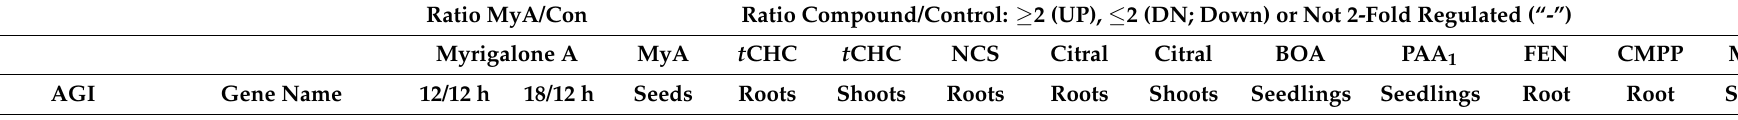
Table 4. Comparison of compound treatment on the expression of selected detoxification, transporter and other genes. Results from myrigalone A (MyA) treated germinating Lepidium sativum seeds were compared to seeds, seedlings or roots cultures of Arabidopsis thaliana treated with t CHC, NCS, citral, BOA, PPA1,